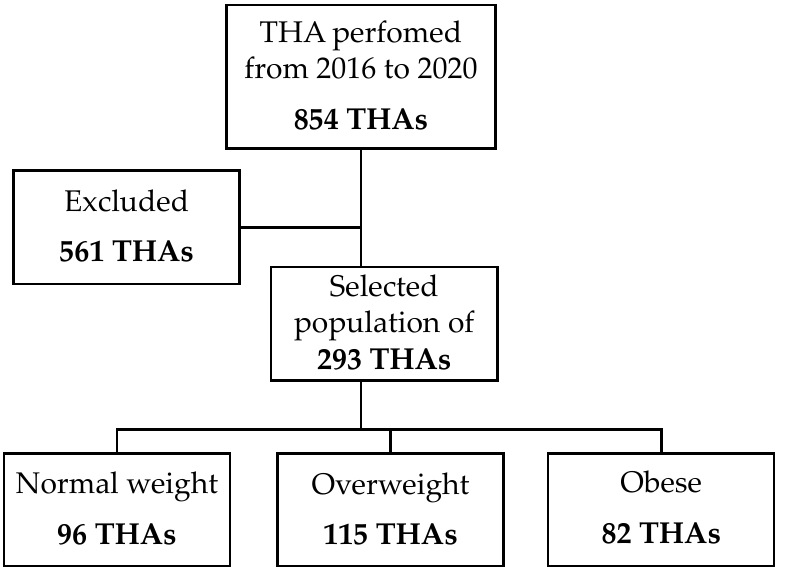
Figure 1. Flow-chart of the